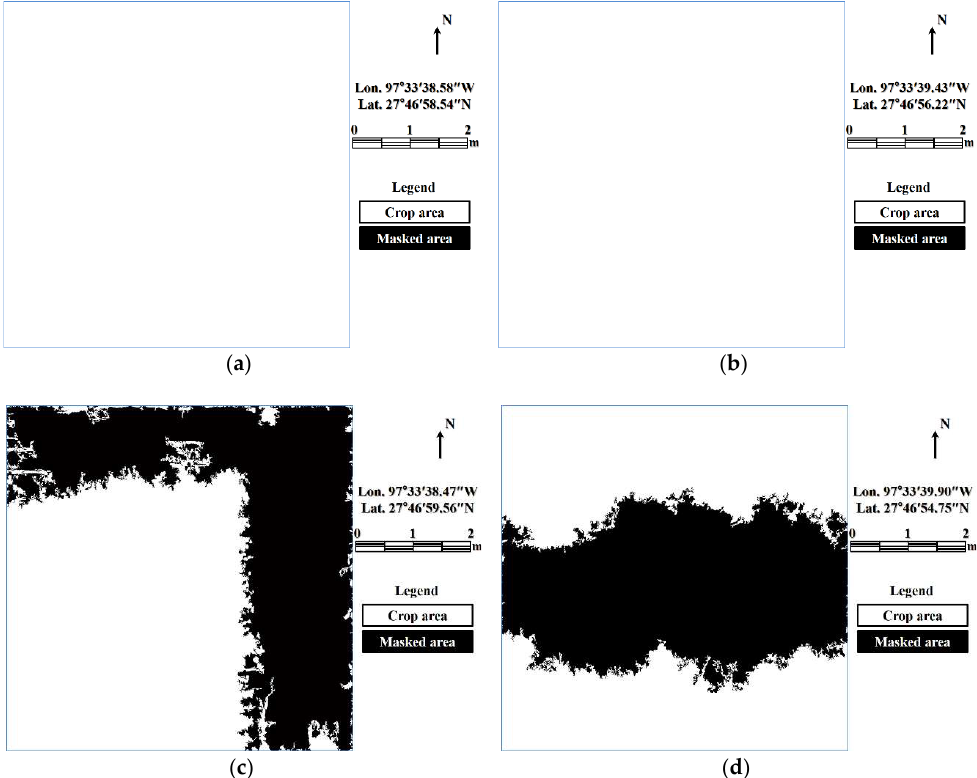
Figure 5. Bare ground masking results in subset images. ( a ) N1; ( b ) S1; ( c ) N2; ( d ) S2.